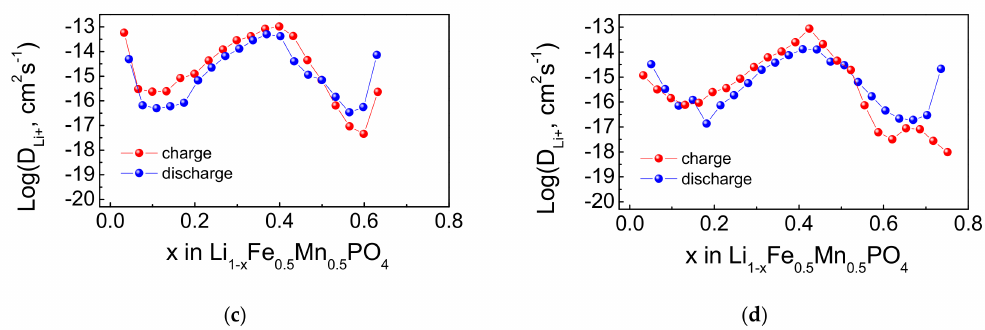
Figure 6. GITT and OCV curves ( a , b ) and di ff usion coe ffi cient D Li + as a function of x Li ( c , d ) for LFMP ( a , c ) and LFMP / C ( b , d ).